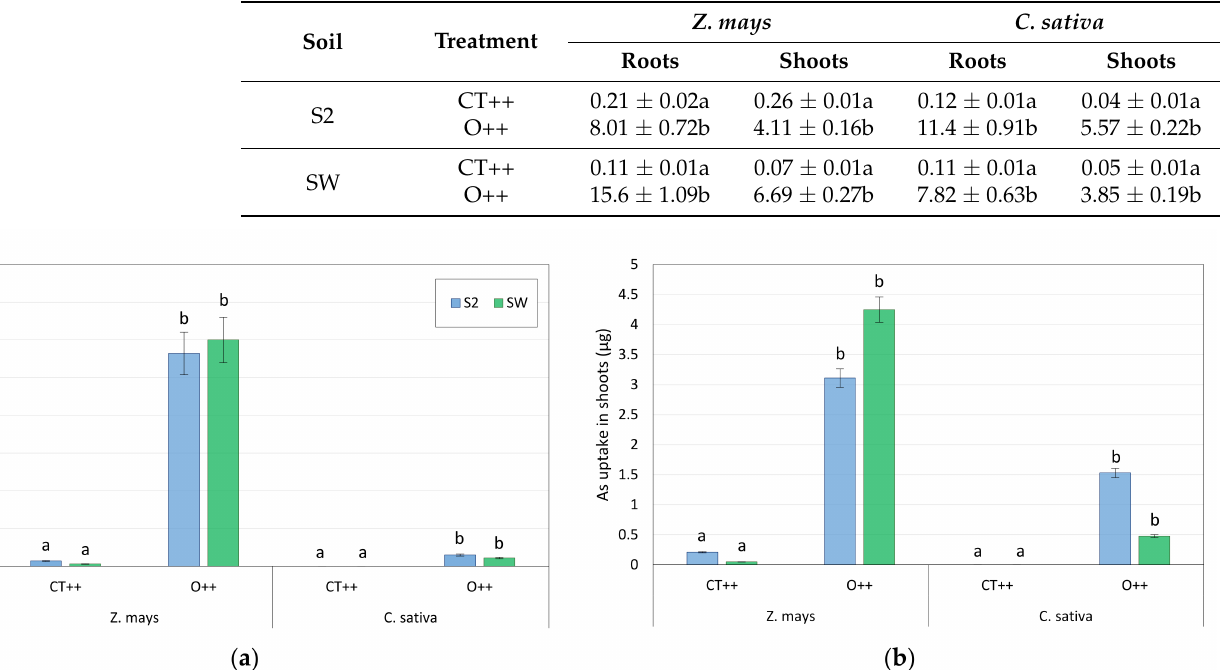
Table 5. Arsenic concentration (mg kg − 1 ) in roots and shoots of Z. mays and C. sativa grown on soil control (CT) and As-contaminated soil treated with oxalate (O). PGPR bacteria (second set of isolates) were added to all soil samples, as indicated by the “++” sign. Values are reported as mean ( n = 3) ± SD. Values with different letters are significantly different at the 5% probability level (Tukey’s test).